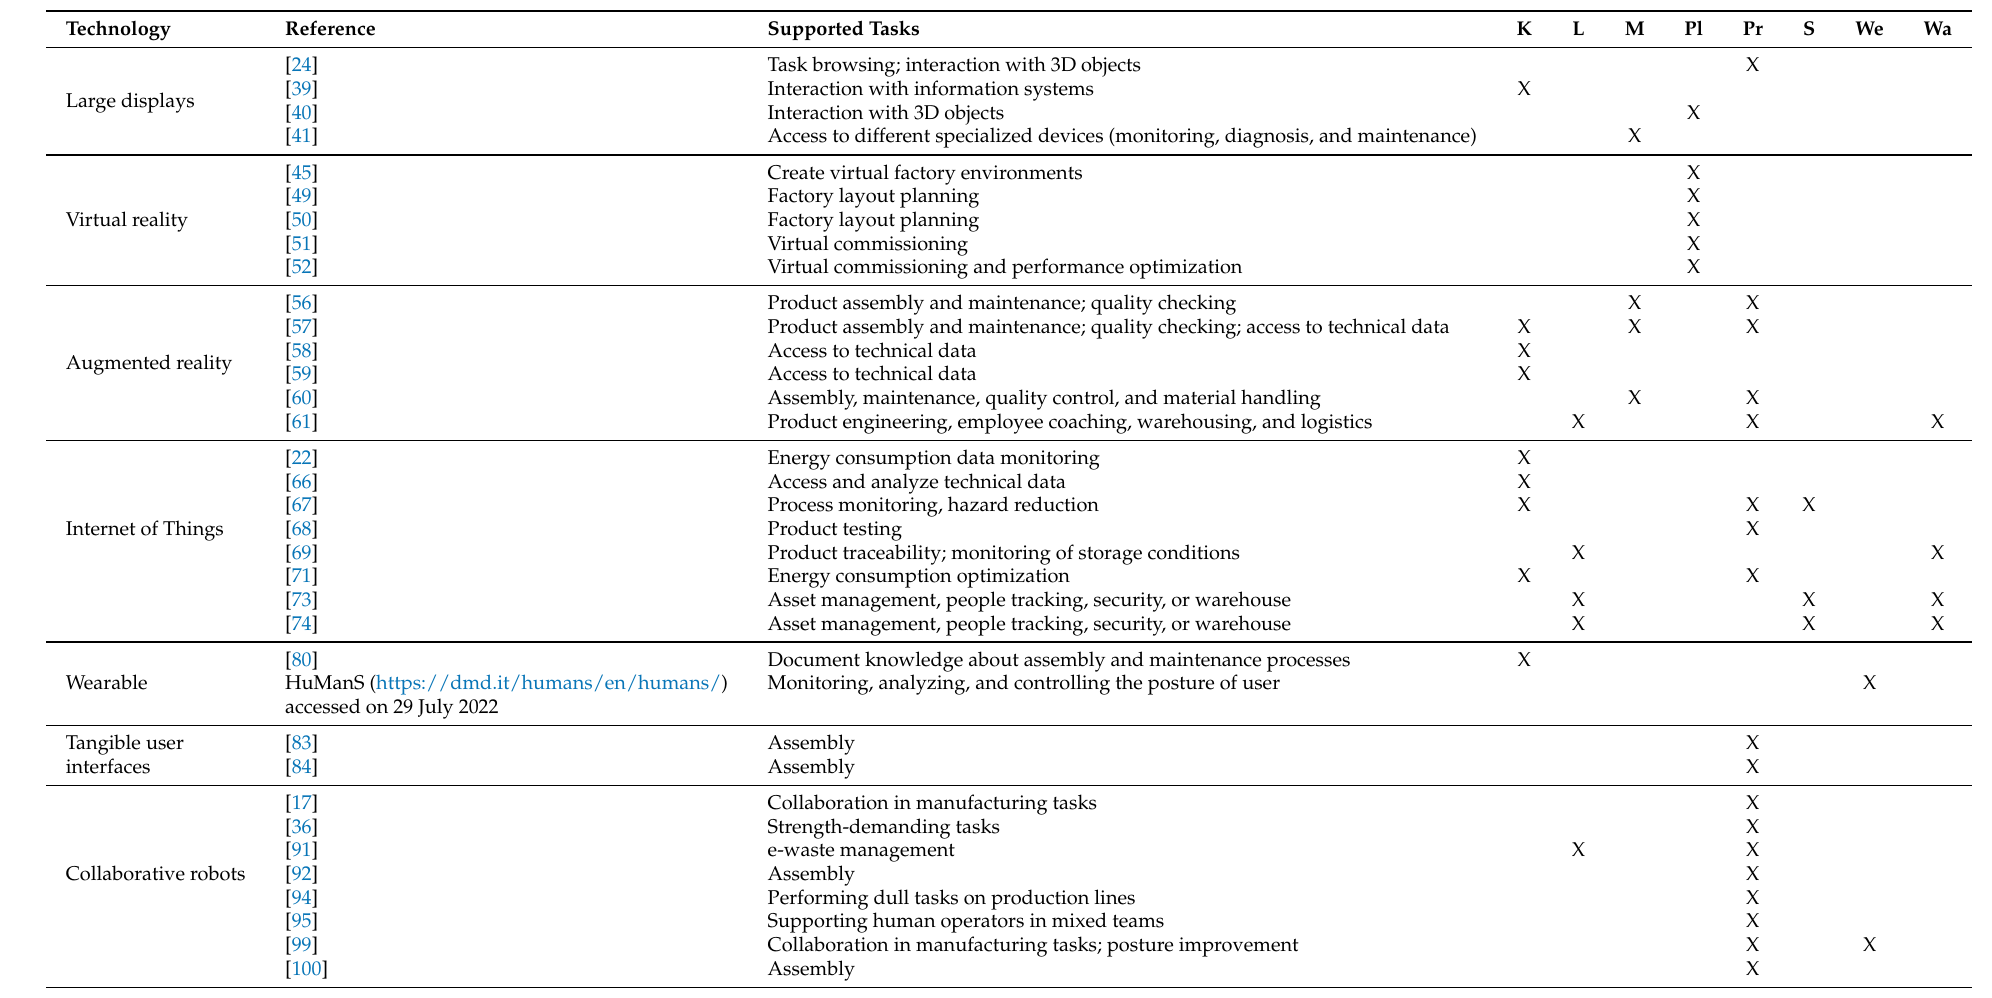
Table 1. Surveyed works classified based on the supported task(s) and production process phases/activities: access to knowledge (K), logistics (L), maintenance